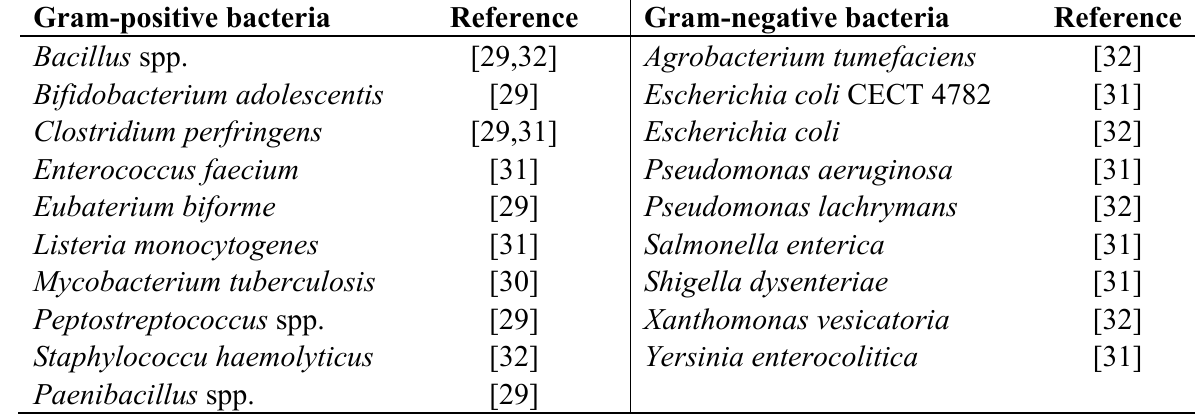
Table 2. Bacterial strains that are inhibited by